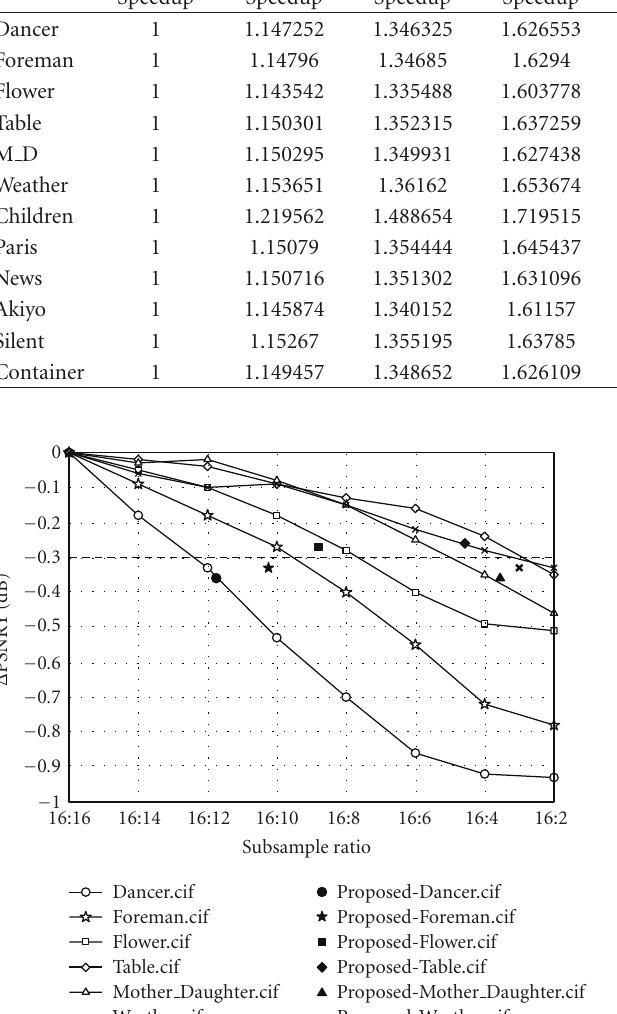
Figure 8: The dynamic quality degradation of the clip “Table” with fixed subsample ratios and proposed